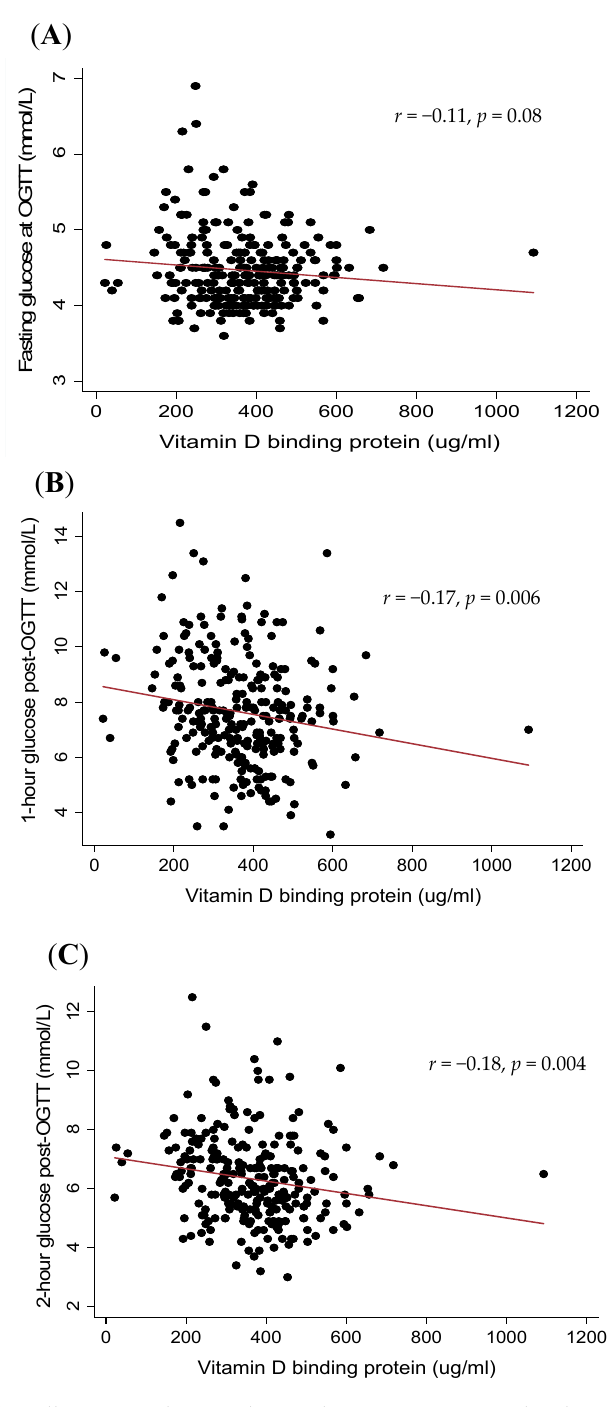
Figure 1. Scatterplots illustrating the correlations between vitamin D binding protein with fasting glucose ( A ); 1 h glucose ( B ); and 2 h glucose ( C ) post-oral glucose tolerance test (OGTT).